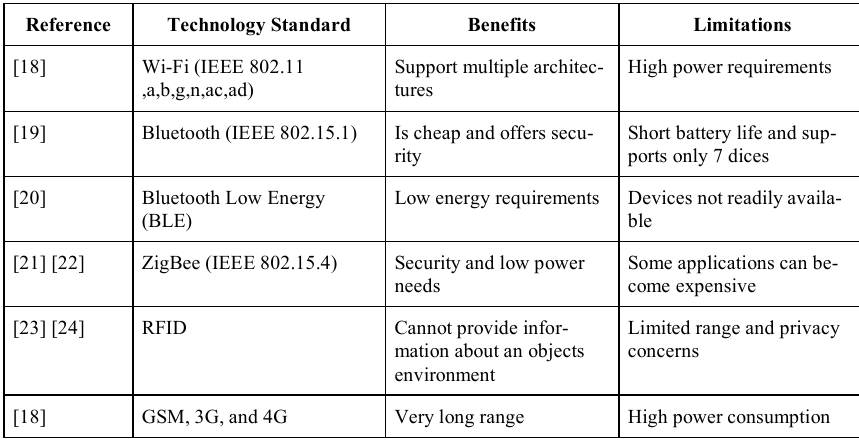
Table 1. IoT Connectivity